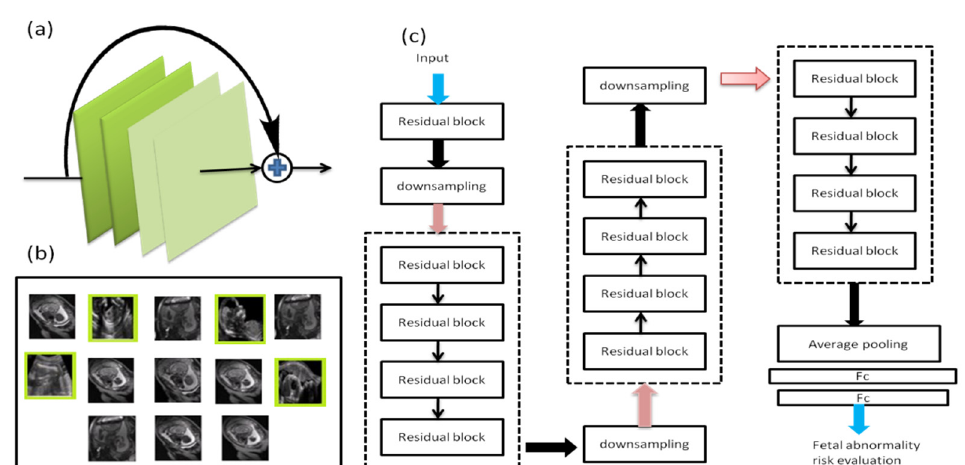
Figure 4. Schematic diagram of basic network architecture. ( a ) The bottleneck blocks, ( b ) The network’s input types, ( c ) Basic architecture of the network.